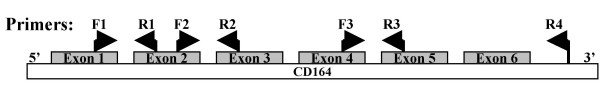
Cartoon of CD164 genomic structure and PCR primer sets.